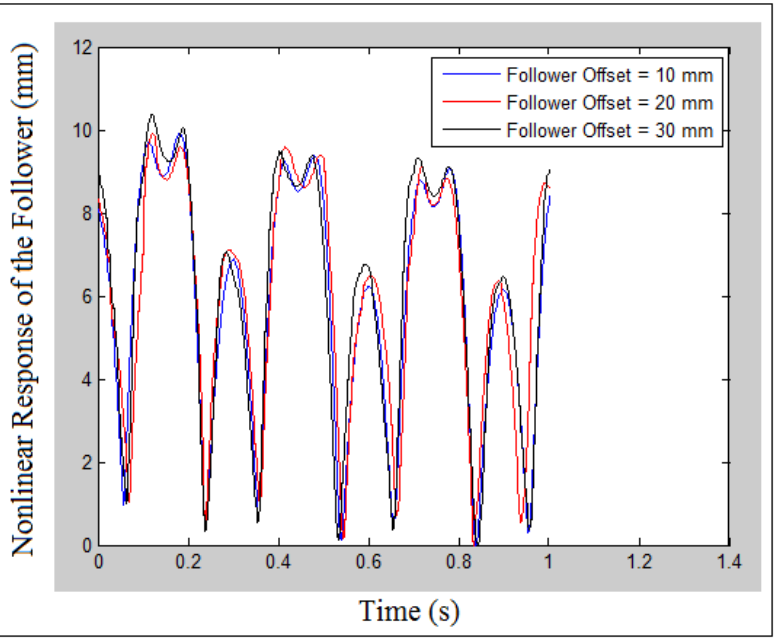
Figure 2. Nonlinear response when the follower offsets to the left at (O = 10, 20, and 30 mm).